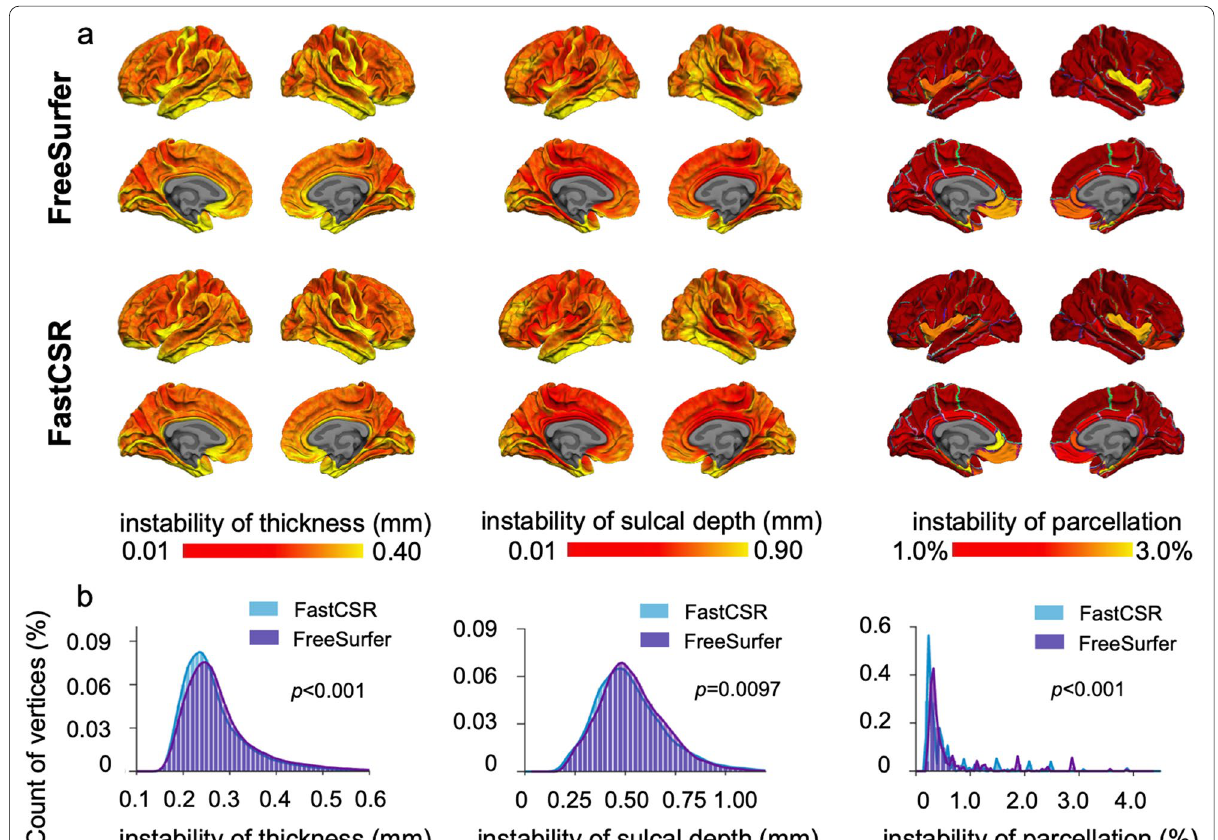
Fig. 8 Surface morphometries and anatomical parcellation from FastCSR showed high intra-subject test–retest reliability. To examine the reliability of our FastCSR method, we measured the instability of surface morphometries and anatomical parcellation in a dataset consisting of 30 participants with 10 repeated scans for each participant. A The instability of morphometrics and parcellations was estimated by the standard deviation across the 10 sessions in each vertex for each participant. The lower instability, indicated by red color, suggests higher test–retest reliability. The average instability map across 30 individuals showed similar distributions for both the FreeSurfer (the upper panel) and FastCSR (the lower panel) methods. However, the FastCSR show lower instability for cortical thickness, sulcal depth, and parcellation than FreeSurfer. B Histograms illustrate the distribution of measurements obtained from FastCSR (blue bars) and FreeSurfer (purple bars). FastCSR shows lower instability relative to FreeSurfer in measures of cortical thickness (two-sample Kolmogorov–Smirnov test, p p 9.700 10 –3 ), and anatomical parcellation (two-sample Kolmogorov–Smirnov test, p = ×